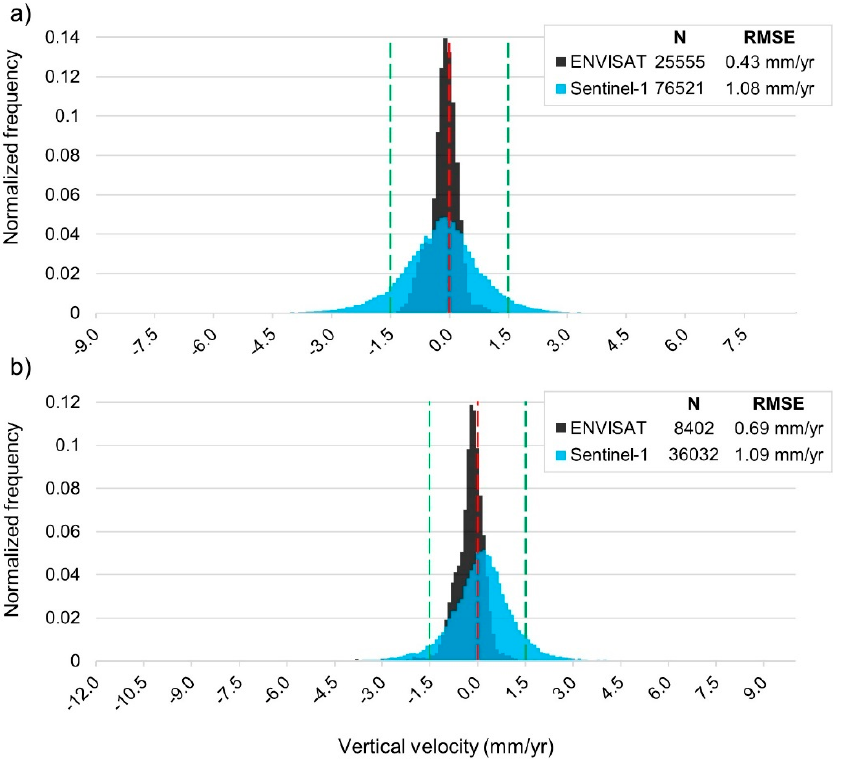
Figure 21. Frequency distribution of PS vertical velocities extracted from ( a ) the Burren (AOI-1) and ( b ) the Navan town (AOI-2) for both satellites. The red line is 0 mm/year, the green lines bound the ±1.5 mm/year velocity range considered as stable. N is the number of PSs; RMSE is the root mean squared error. The distributions are normalized to the total number of PSs retrieved for each satellite. Directly comparing velocity data obtained from the two satellites is not possible as the LOS angles are different. Therefore, for this comparison velocities calculated along the LOS of each satellite were projected along the vertical direction according to the incidence angle of each PS.